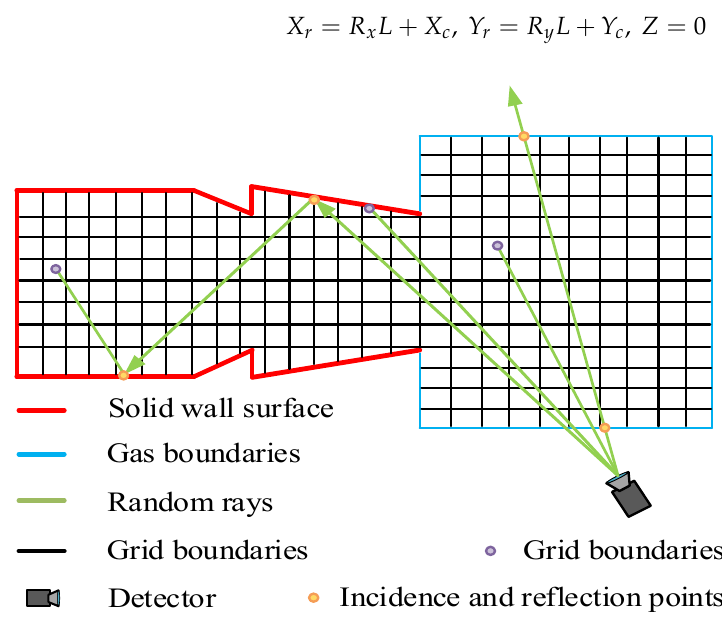
Figure 3 . Schematic diagram of backtracking of random rays. Figure 3. Schematic diagram of backtracking of random